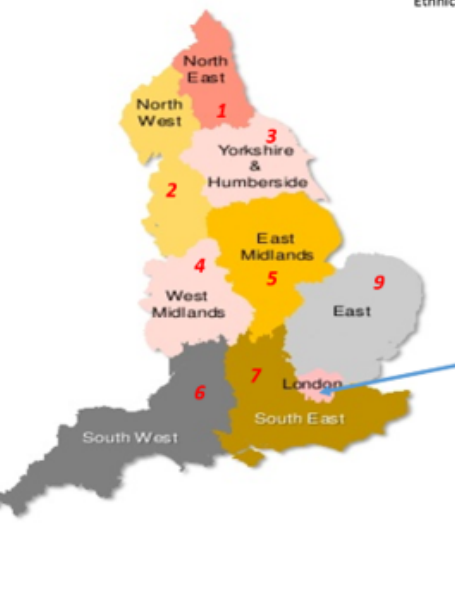
Figure 1. Data from 2011, showing ethnic minority populations across the regions of England